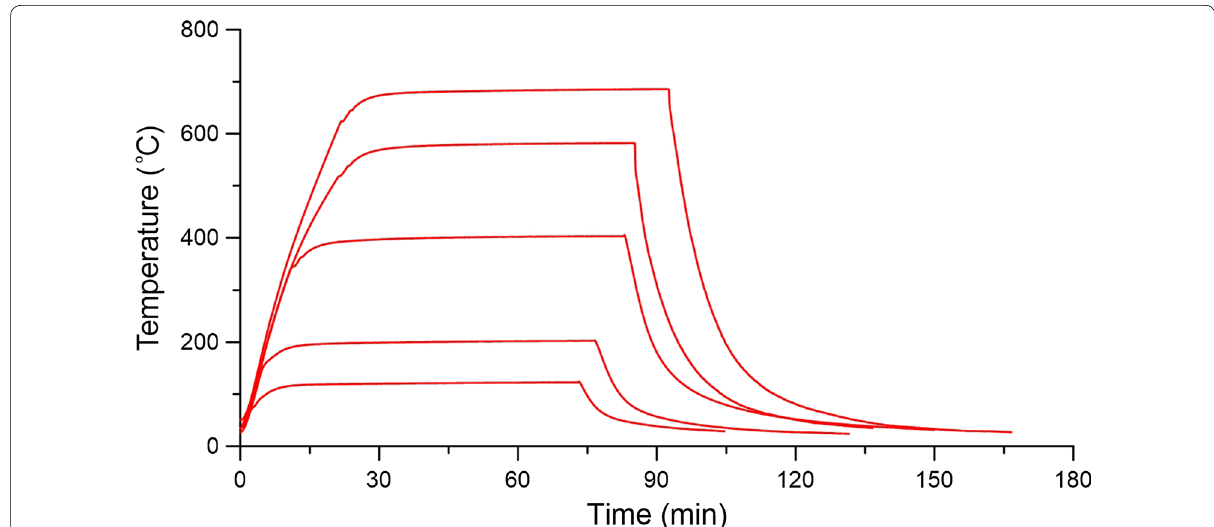
Fig. 9 Temperature curves during heating and cooling at different target temperatures in a thermal demagnetization